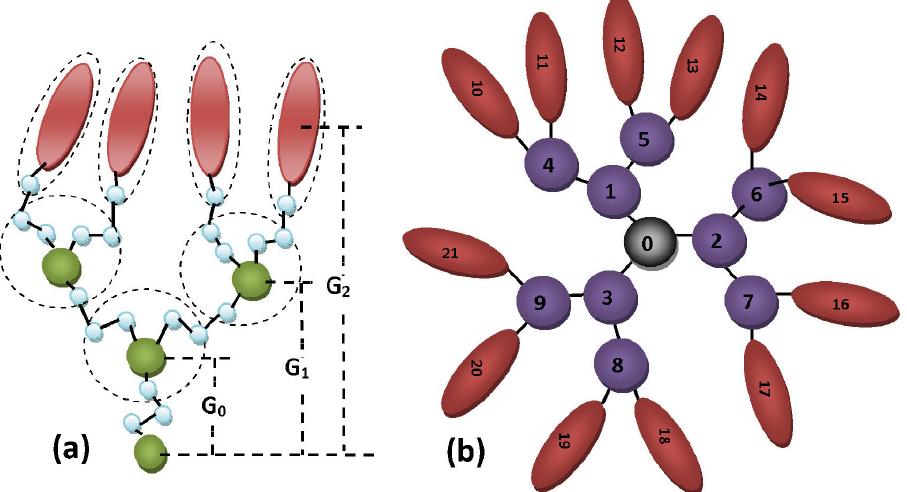
Figure 1. ( a ) Coarse grain representation of an end-functionalized second generation liquid = 2 . The dashed lines around groups of dendritic units crystalline (LC) dendron with f c indicate coarse-gained united atoms; and ( b ) coarse-grained model for a third generation liquid crystalline dendrimer (LCDr) composed of three dendrons linked on a spherical D core ( G 2 3